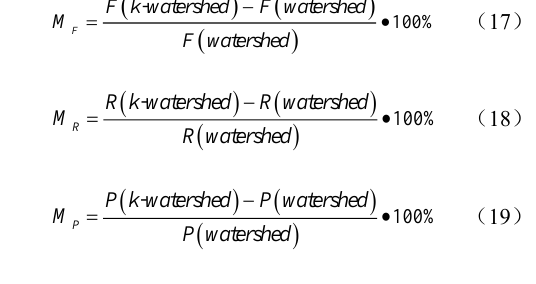
Table 1. LiDAR single-wood split F score verification Index for